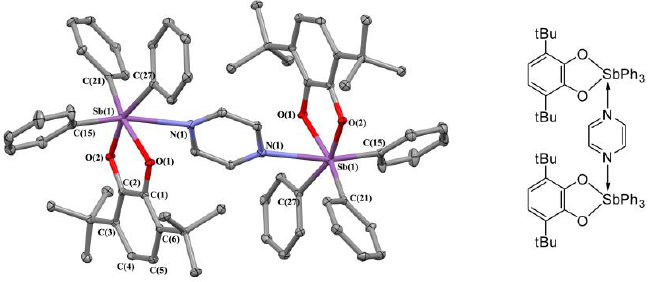
Figure 1. The X-ray structure of 1 (thermal ellipsoids here and below of 50% probability). The hy- drogen atoms are omitted. The selected bond lengths ( Ǻ ) and angles (°): Sb(1)-O(1) 2.0194(12), Sb(1)-O(2) 2.0326(12), Sb(1)-N(1) 2.773(5), Sb(1)-C(15) 2.1246(19), Sb(1)-C(21) 2.1433(18), Sb(1)-C(27) 2.1434(18), O(1)-C(1) 1.353(2), O(2)-C(2) 1.361(2); O(1)-Sb(1)-O(2) 79.69(5), O(1)-Sb(1)-C(21) 155.31(6), O(2)-Sb(1)-C(27) 160.75(6), N(1)-Sb(1)-C(15) 167.87(6).